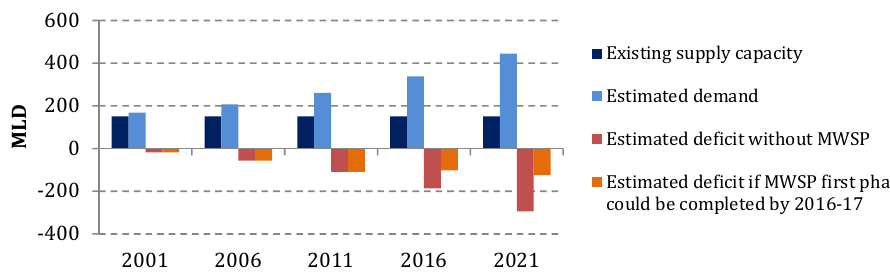
Figure 3. KUKL service area maximum water supply capacity for 2013 and estimated demand deficit.